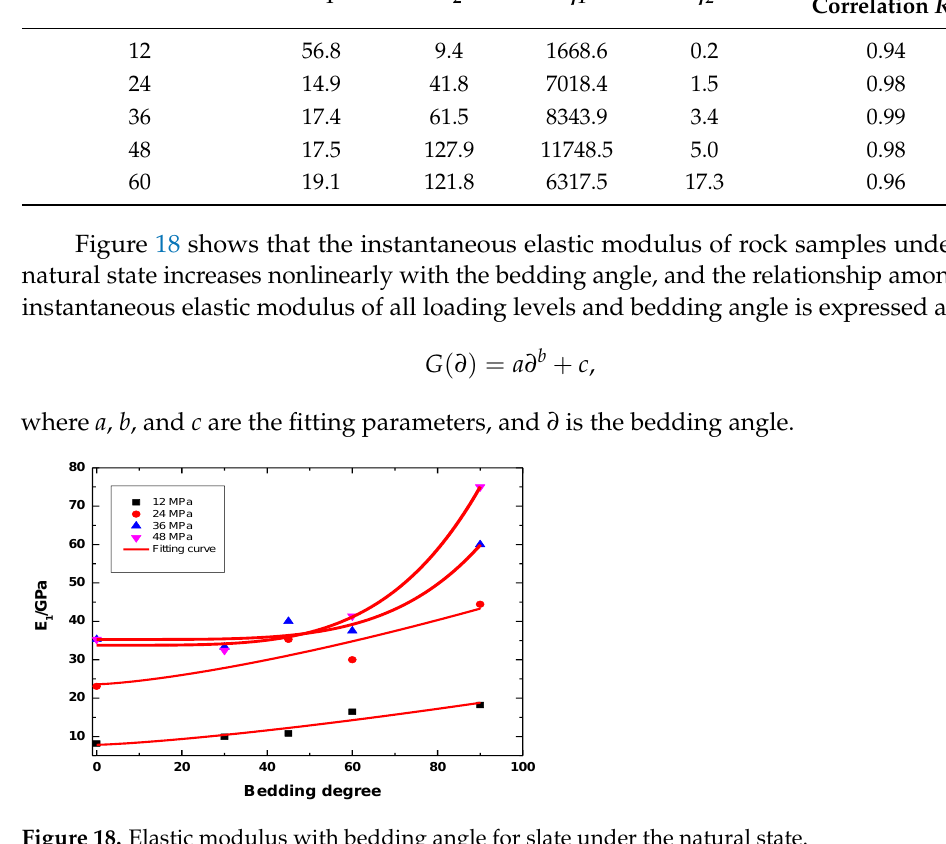
Table 12. Parameter inversion results of 0° bedding angle for slate under the natural state. Stress Level/MPa